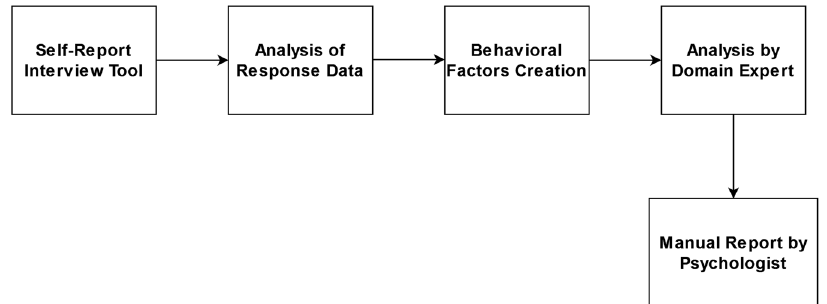
Fig. 1 The procedure followed for the conventional or traditional diagnosis of juvenile delinquency. This type of manual process is dependent upon the experience of the